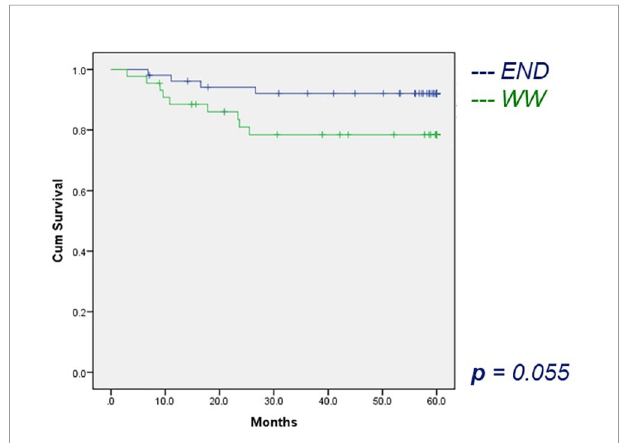
FIGURE 2 | The 5-year regional recurrence-free